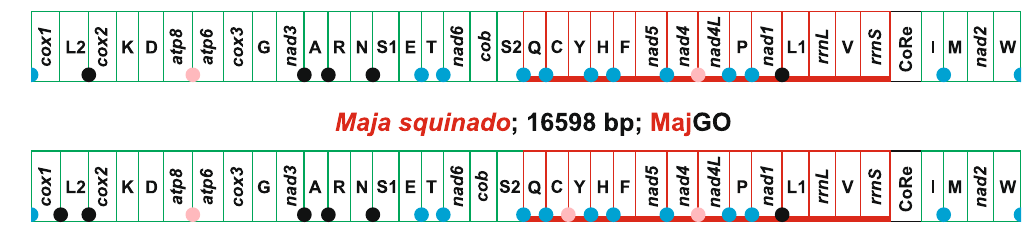
(Fig. 2). Both mtDNAs present intergenic spacers of variable size (Fig. 2, Supplementary Fig. S1). The newly determined mtDNAs share the same gene order MajGO, which is different from any other animal GO so far sequenced (Fig. 2). In MajGO, all the genes located on the β -strand form a single block, placed between trnE and CoRe. For more details on Maja mtDNAs, the reader should refer to the Supplementary Figs S1–S6. The phylogeny of Brachyura. The mitochondrial phylogenomics of Brachyura obtained from 56 T.PRO set is shown in Fig. 3. The majority (39 up to 50) of the nodes of the tree receive good statistical support (UFBoot val- ues > 90%). Only three basal nodes of the Thoracotremata clade does not receive any statistical support (UFBoot values < 50%). The overall phylogenetic outputs are in agreement with those presented in Fig. 1. Dynomene pilum- noides (Dromioidea) and the Homolidae species (Homoloidea) cluster together. The Raninidae taxa (Raninoidea) are sister group of Eubrachyura. Within this clade, Heterotremata and Thoracotremata are monophyletic groups of Brachyura, which is based on nuclear genes 5 . Likewise, the superfamilies Ocypodoidea and Grapsoidea do